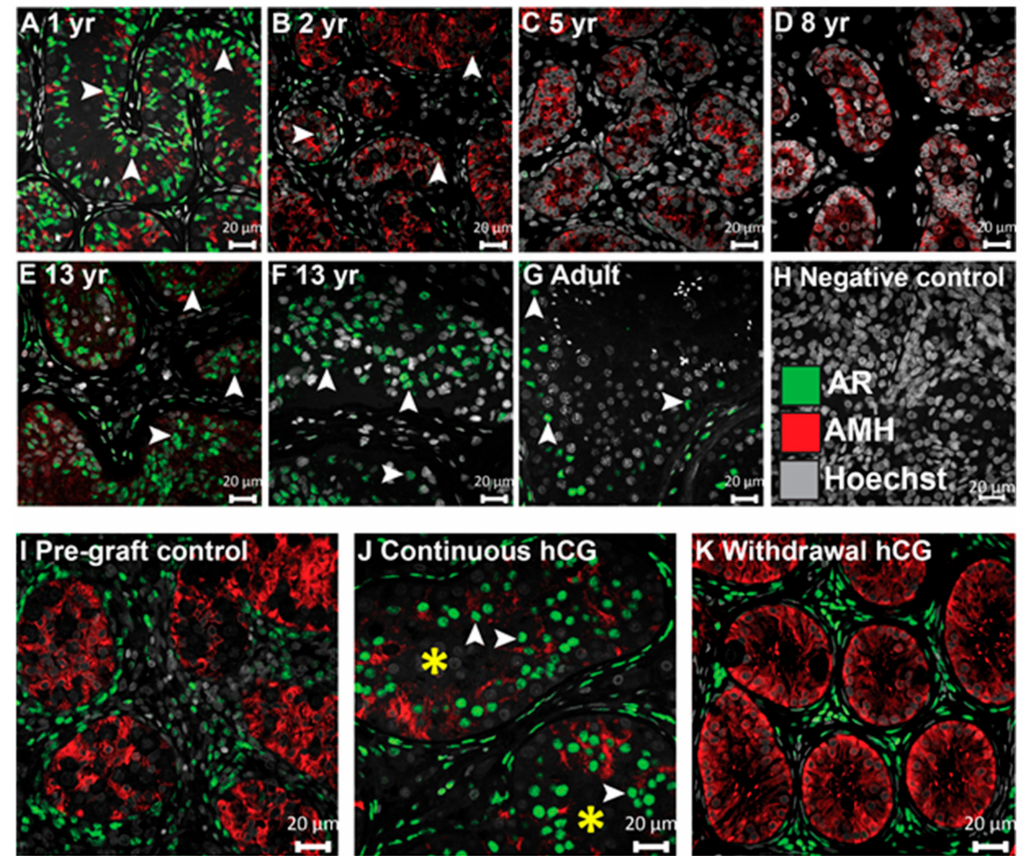
Figure 6. Continuous hCG stimulation induces AR expression in Sertoli cells but fails to